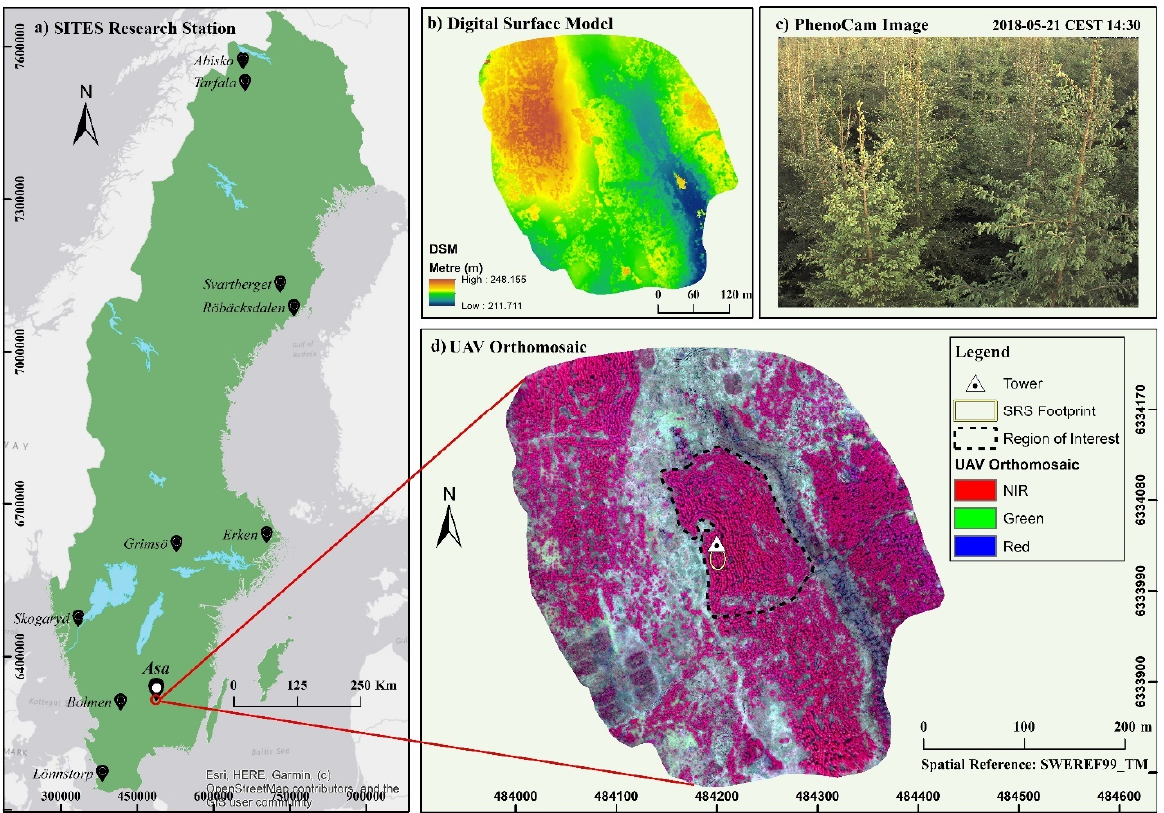
Figure 1. Map showing the location of Asa Research Station ( a ), Digital Surface Model (DSM) of the site ( b ), a sample PhenoCam image ( c ) and a UAV Orthomosaic ( d ). PhenoCam and SRS sensors are installed on tower and the ellipse south to tower refers to the ground projected SRS footprint.